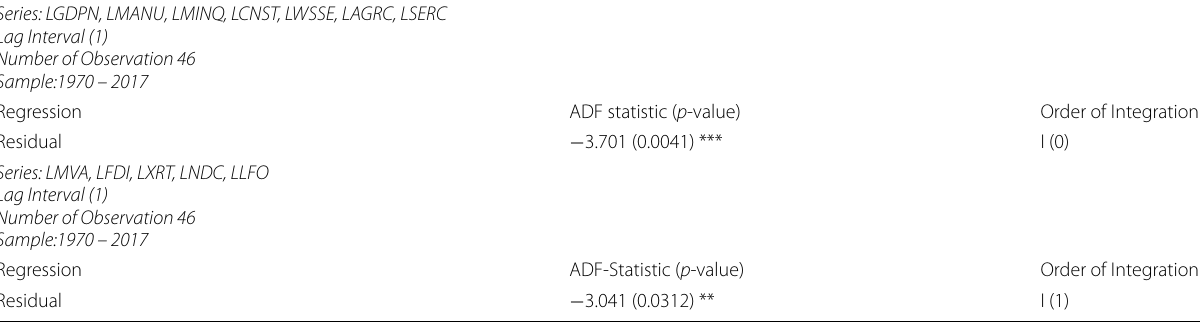
Asterisk ***, ** indicates significance level at 1% and 5%